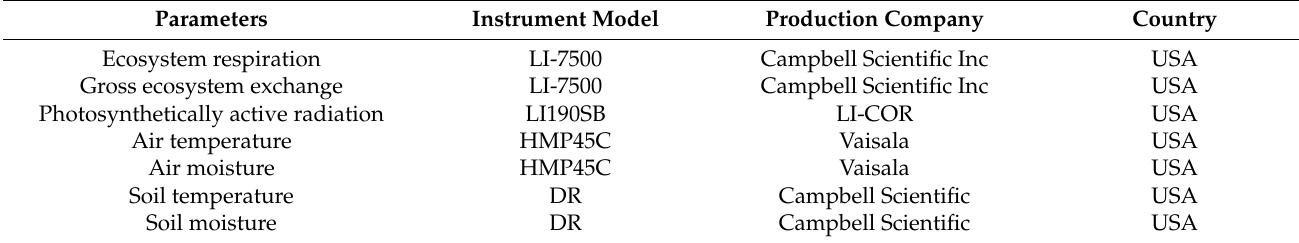
Table 1. Instrument information for measuring meteorological and CO 2 fluxes.